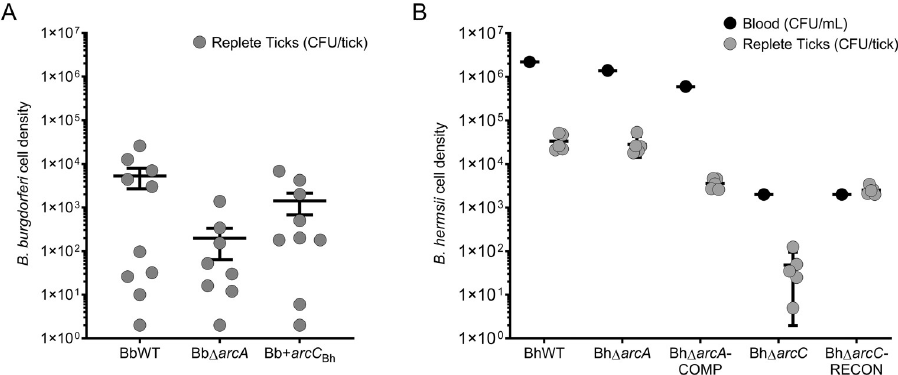
Fig 6. Acquisition of B . burgdorferi and B . hermsii arc mutants by their respective tick vectors. A) Uninfected, larval I . scapularis ticks fed on mice infected with B . burgdorferi (either BbWT, Bb Δ arcA or Bb+ arcC Bh ) and upon repletion individual ticks were crushed and plated, and spirochetes were enumerated. B) Uninfected, nymphal O . hermsi ticks fed on spirochetemic mice infected with B . hermsii (wild-type or arc mutants) and spirochetes were enumerated by plating infected blood and crushed O . hermsi within 24 h of ticks dropping off mice.